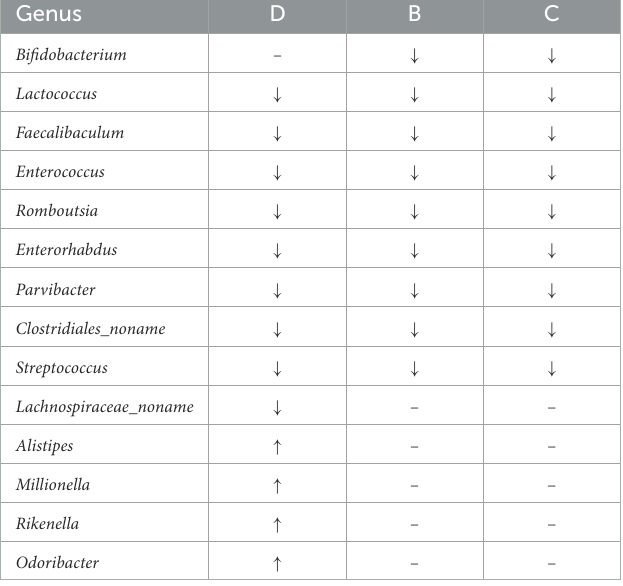
TABLE 3 Detailed analysis of the genera with differential relative abundances.